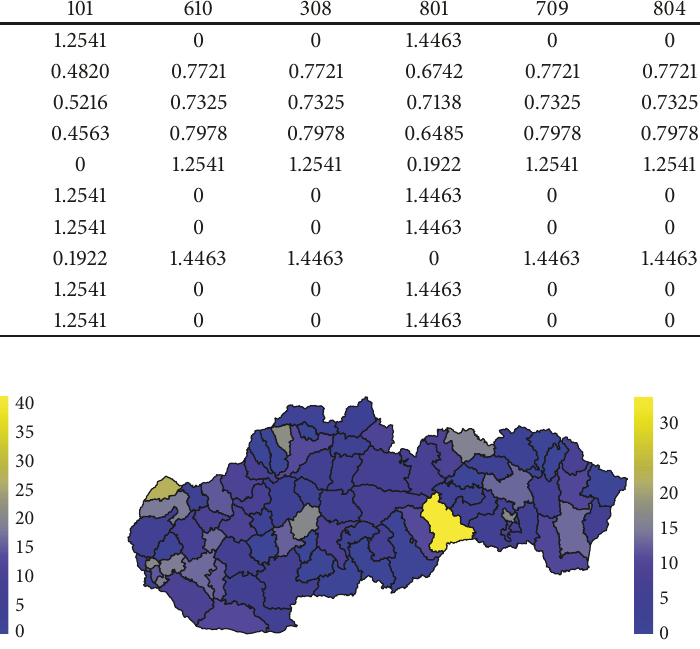
Figure4:Theaverageannualstandardisedmortalityrateofthemale sex in the individual districts of the Slovak Republic for the period from 2013 to